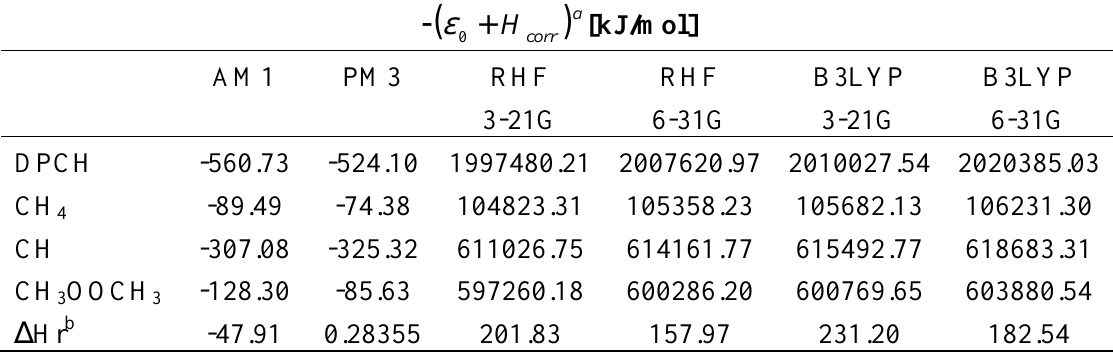
Table 3 . Calculated electronic energy and heat of reaction (in Hartree